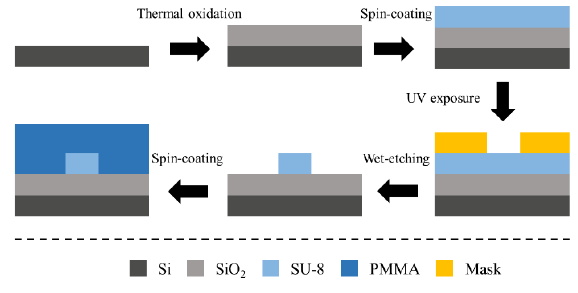
Figure 4. The fabrication process of the AWG.